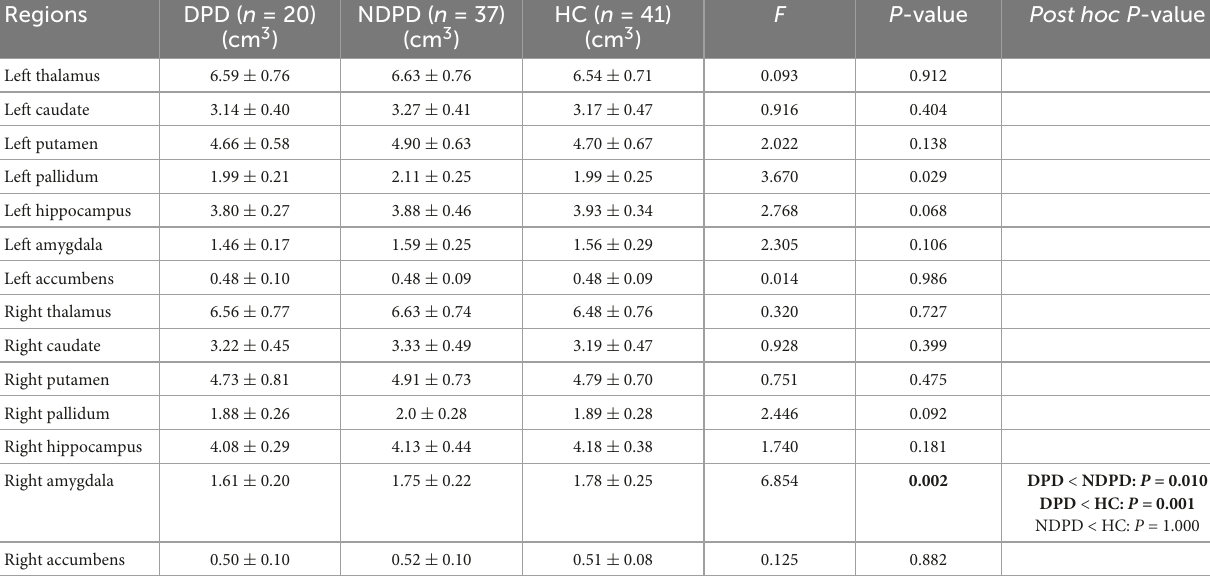
TABLE 5 The differences of subcortical GM volumes among three